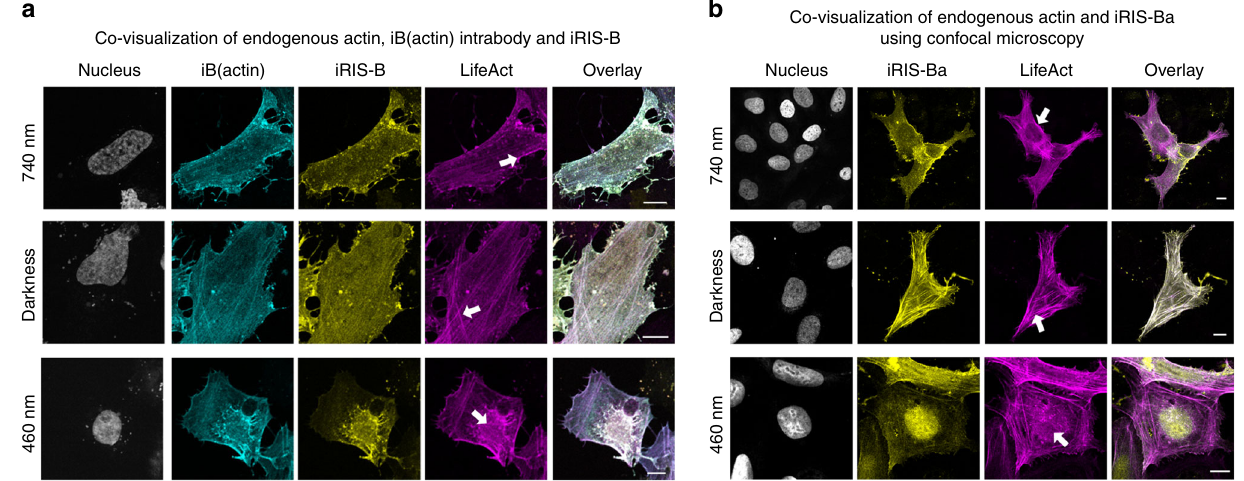
Fig. 4 Covisualization of optically controlled iB(actin) and its endogenous target. a Colocalization of the components of light-driven iB(actin) – iRIS-B system and light-independent probe for actin visualization (LifeAct-miRFP703 fusion) on plasma membrane (740 nm), on stress fi bers and in cytoplasm (darkness), and in the nucleus (460 nm). Arrows indicate compartments highlighted by all three probes. Confocal microscopy; scale bar, 10 μ m. b Colocalization of iRIS-Ba and light-independent probe for actin visualization (LifeAct-miRFP703 fusion) on plasma membrane (under 740 nm), on stress fi bers and in cytoplasm (in darkness), and in the nucleus (under 460 nm). Arrows indicate regions highlighted by both iRIS-Ba and LifeAct. Confocal microscopy; scale bar, 10 μ